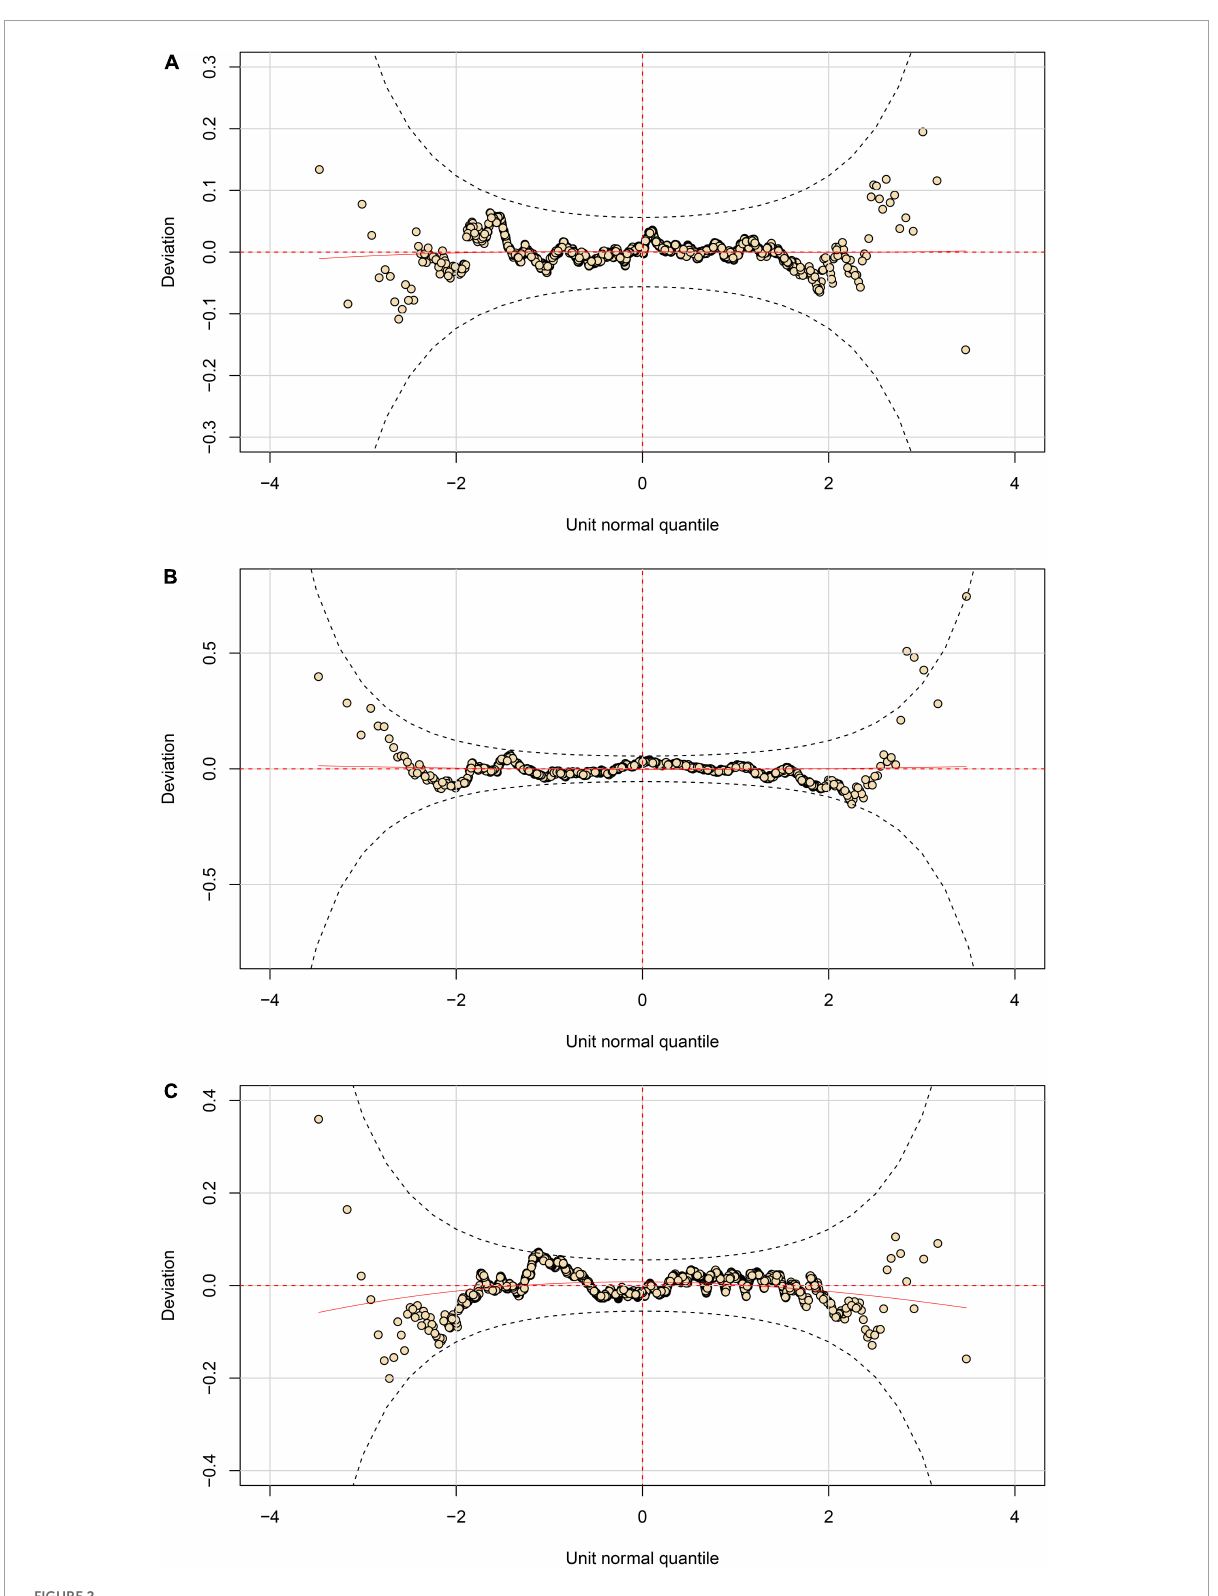
FIGURE2 Worm plots of fitted GAMLSS models. (A) Height for boys; (B) forced vital capacity for girls; (C) sit and reach test for